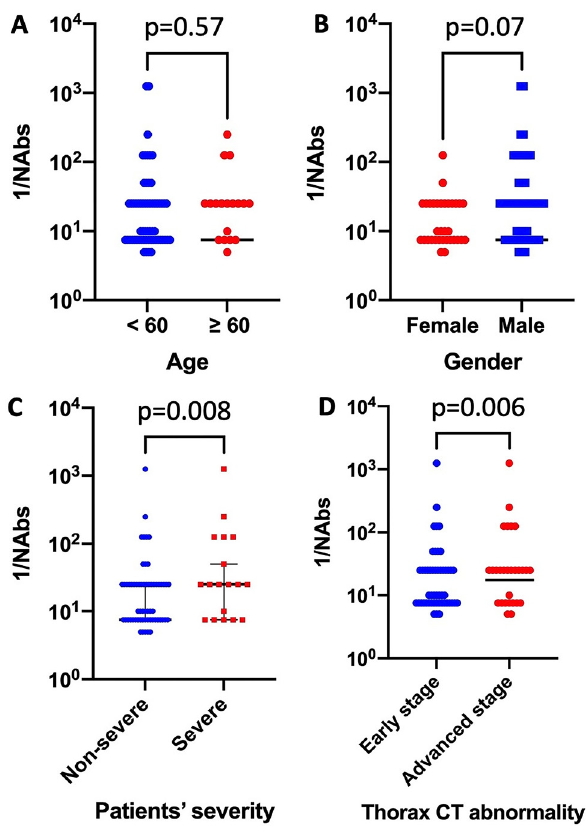
Figure 2: Distribution of neutralizing antibody titers against severe acute respiratory syndrome-Coronavirus-2 in different patient groups. CT, computed tomography, NAb: neutralizing